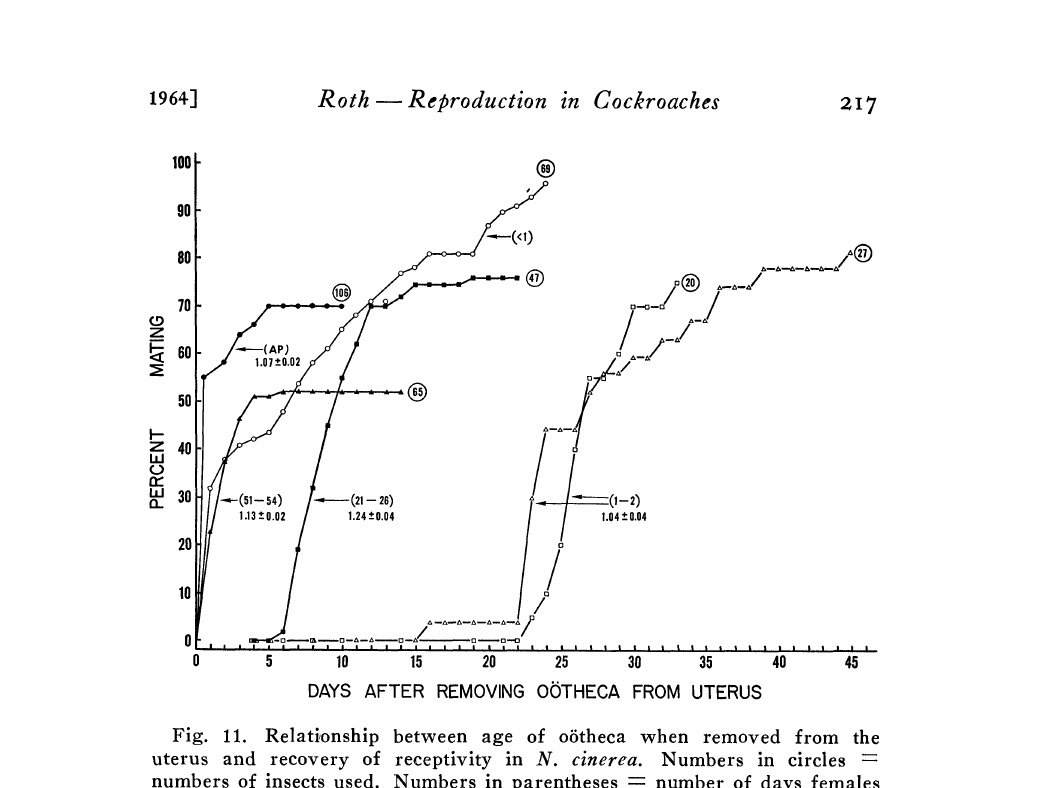
Fig. 11. Relati, onship between age of o6theca when removed from the uterus and recovery of receptivity in N. cinerea. Numbers in circles numbers of insects used. Numbers in parentheses number of days females were pregnant when their o6thecae were removed from the uteri. Numbers under parentheses mean length (ram.) -4- standard errors of the o6cytes, measured at the time of mating (except for females represented by open square; the o6cytes of these females were measured <24 hr. after mating). (AP) females that gave birth normally; fifty-five per cent of the females mated <24 hr. after parturition and these are plotted at 0.5 day. The females of this group that failed to mate oviposited 6-10 days after partu- rition. Open circles virgin females; all other groups had mated prior to ovipositing. Open squares each of the females in this group were confined with 2 males continuously until they mated; females examined daily for spermatophores. The females in all other groups were tested for receptivity once a day for one hr. (28 8 1) and were removed when they mated. The per cent mating is expressed as accumulative data. (Room